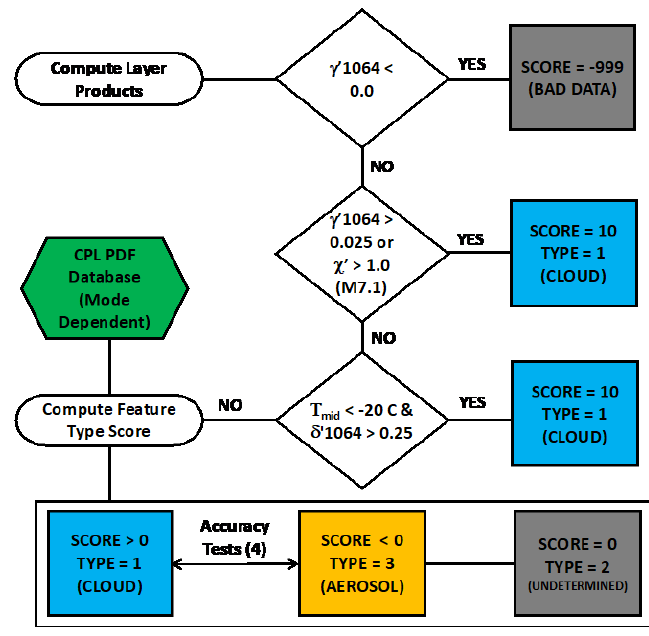
Figure 4. A flowchart of the CATS V3 L2O CAD